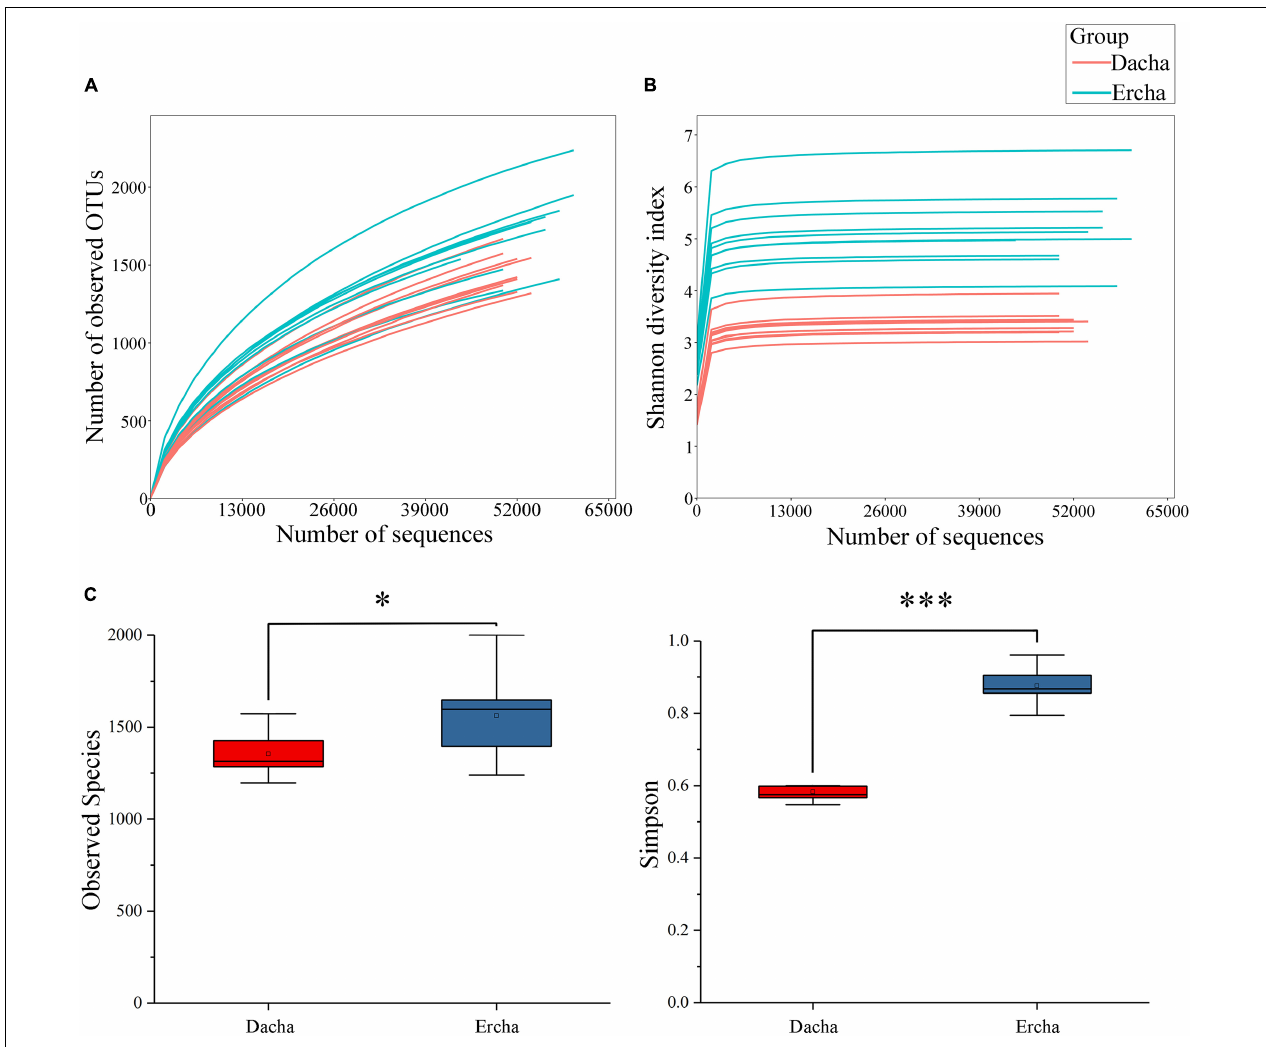
FIGURE 2 | Dilution (A) and Shannon index (B) curves, and differences in alpha diversity (C) (NS: P > 0.05. ∗ 0.01 < P < 0.05, ∗∗∗ P < 0.001).